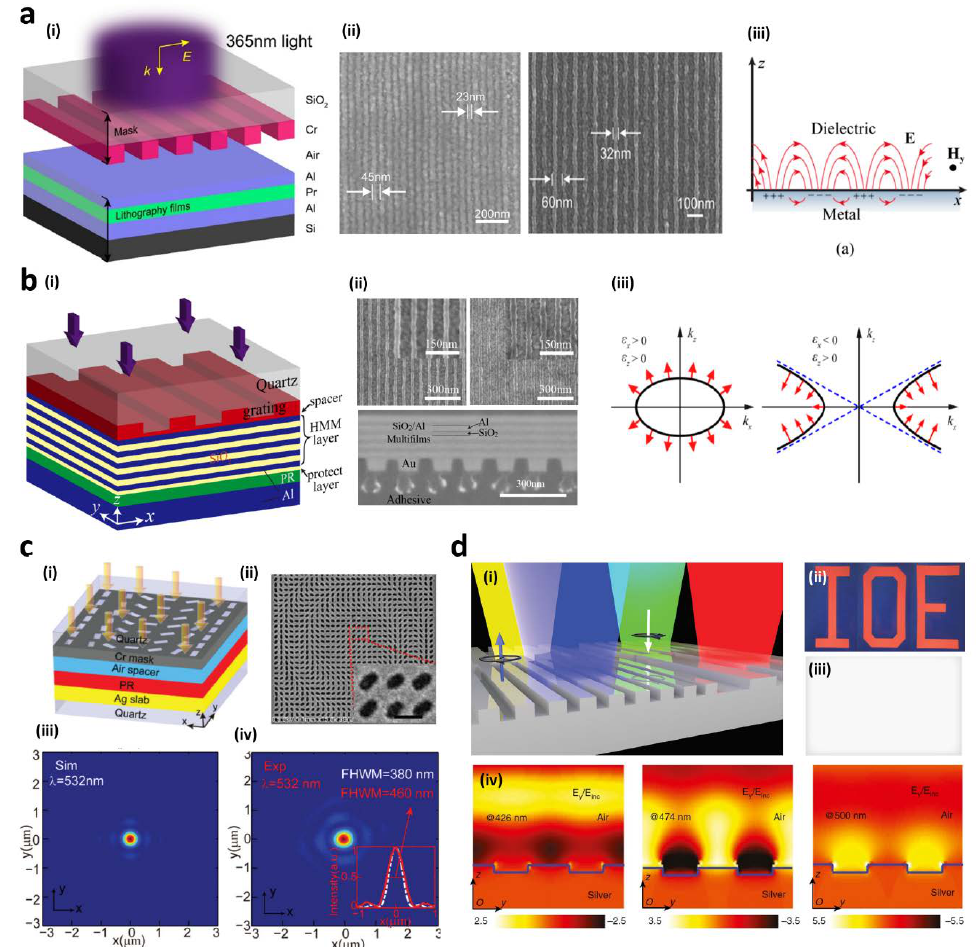
Figure 4. ( a ) (i) Schematic of a structure of the surface plasmon interference lithography (SPIL), (ii) SEM images of the patterned grating results with 22 and 32 nm half-pitches [129], (iii) schematic of surface plasmon polaritons (SPPs) on dielectric-metal interface [130]. ( b ) (i) Schematic of a structure of surface plasmon polaritons (BPPs) interference lithography with hyperbolic metamaterials (HMMs), (ii) SEM images of the patterned grating results of (left) titanium dioxide, (right) gold and (bottom) cross section of the BPPs structure, respectively [114], (iii) the dispersion relations of (left) natural materials and (right) HMMs. The group velocity is indicated by the arrows [130]. ( c ) (i) Schematic of a structure of the surface plasmon imaging lithography, (ii) SEM image of the fabricated metalens (scale bar, 200 nm), (iii and iv) the cross section intensity distribution for circularly polarized light with 532 nm wavelength, (iii) the simulated and (iv) experimental results [115]. ( d ) (i) Schematic of a structural coloring device using the plasmonic lithography structure, (ii and iii) microscopic images of a metasurface indicating the letters “IOE” with (ii) 45°/-45° and (iii) 45°/45°, respectively, (iv) the maps of electric field intensity distribution with a period of the wavelength of 400 nm at 426, 474, and 500 nm from left to right, respectively [128]. Reproduced with permission from ( a–i, ii ) [129]; Copyright 2019 American Chemical Society, ( b–i, ii ) [114]; OSA Publishing, 2018, ( a–iii, b–iii ) [130]; MDPI, 2016, ( c ) [115]; Royal Society of Chemistry, 2015, and ( d ) [128]; De Gruyter, 2017.